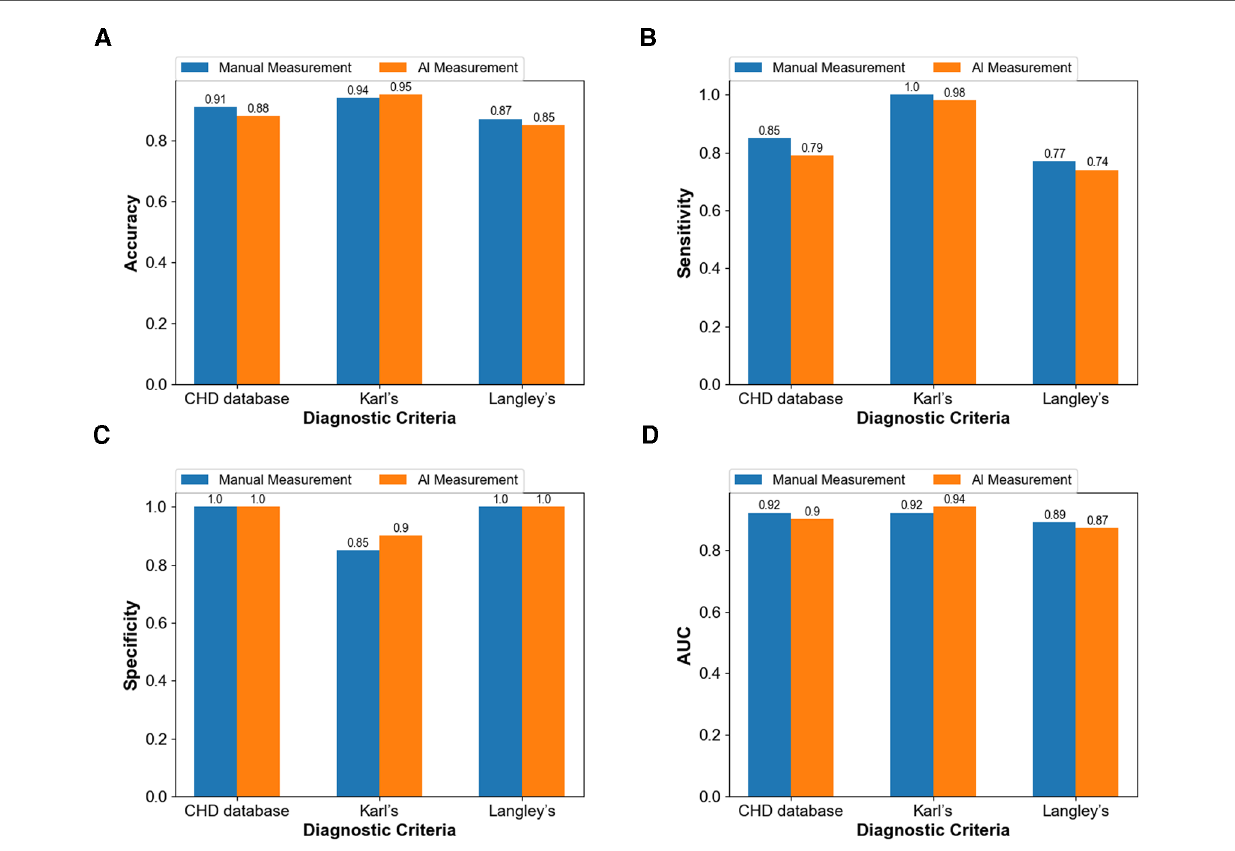
FIGURE 8 Comparison between the diagnostic capacity of the manual method and of the intelligent measurement ( A ) diagnostic accuracy ( B ) diagnostic sensitivity ( C ) diagnostic speci fi city ( D ) diagnostic